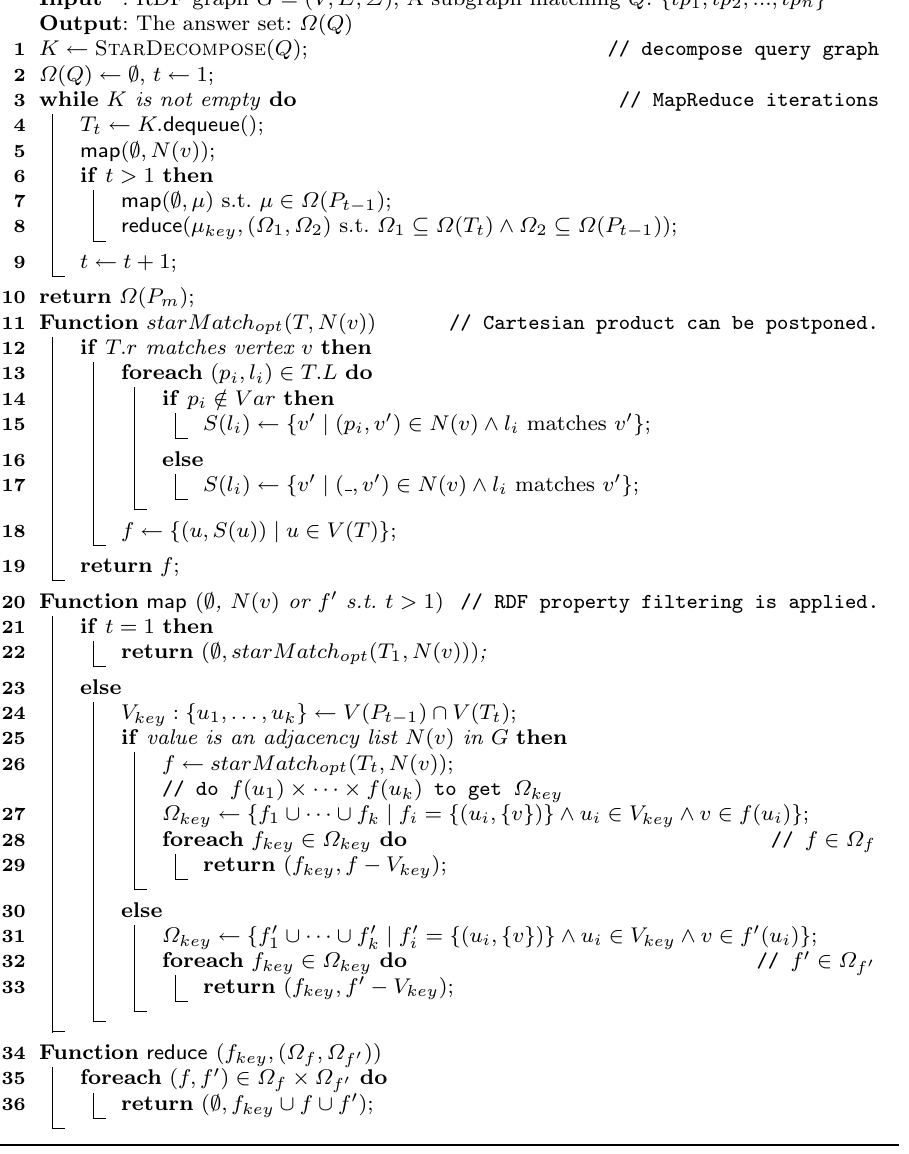
Algorithm 4: StarMR